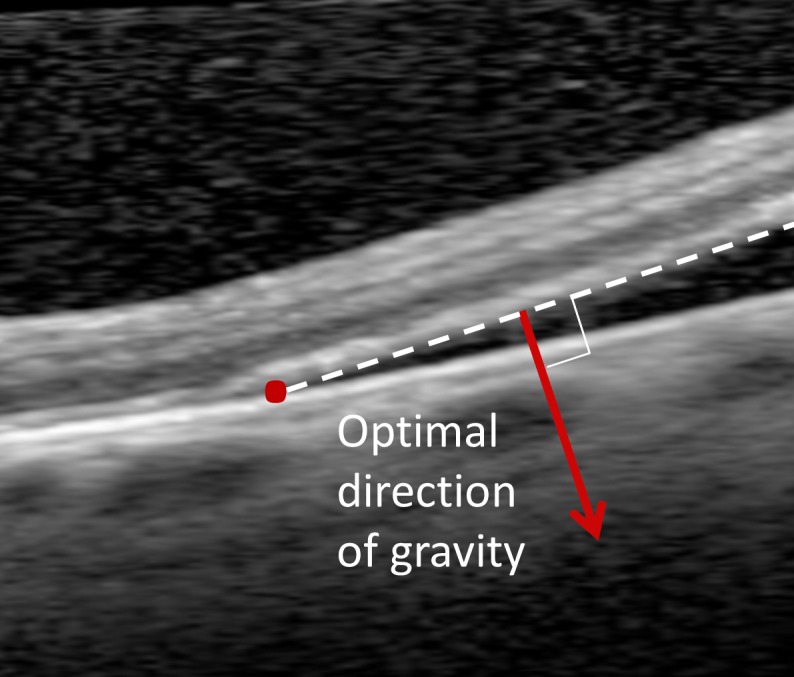
The optimal direction of gravity was defined as perpendicular to the detached retina closest to the fovea (red arrow).